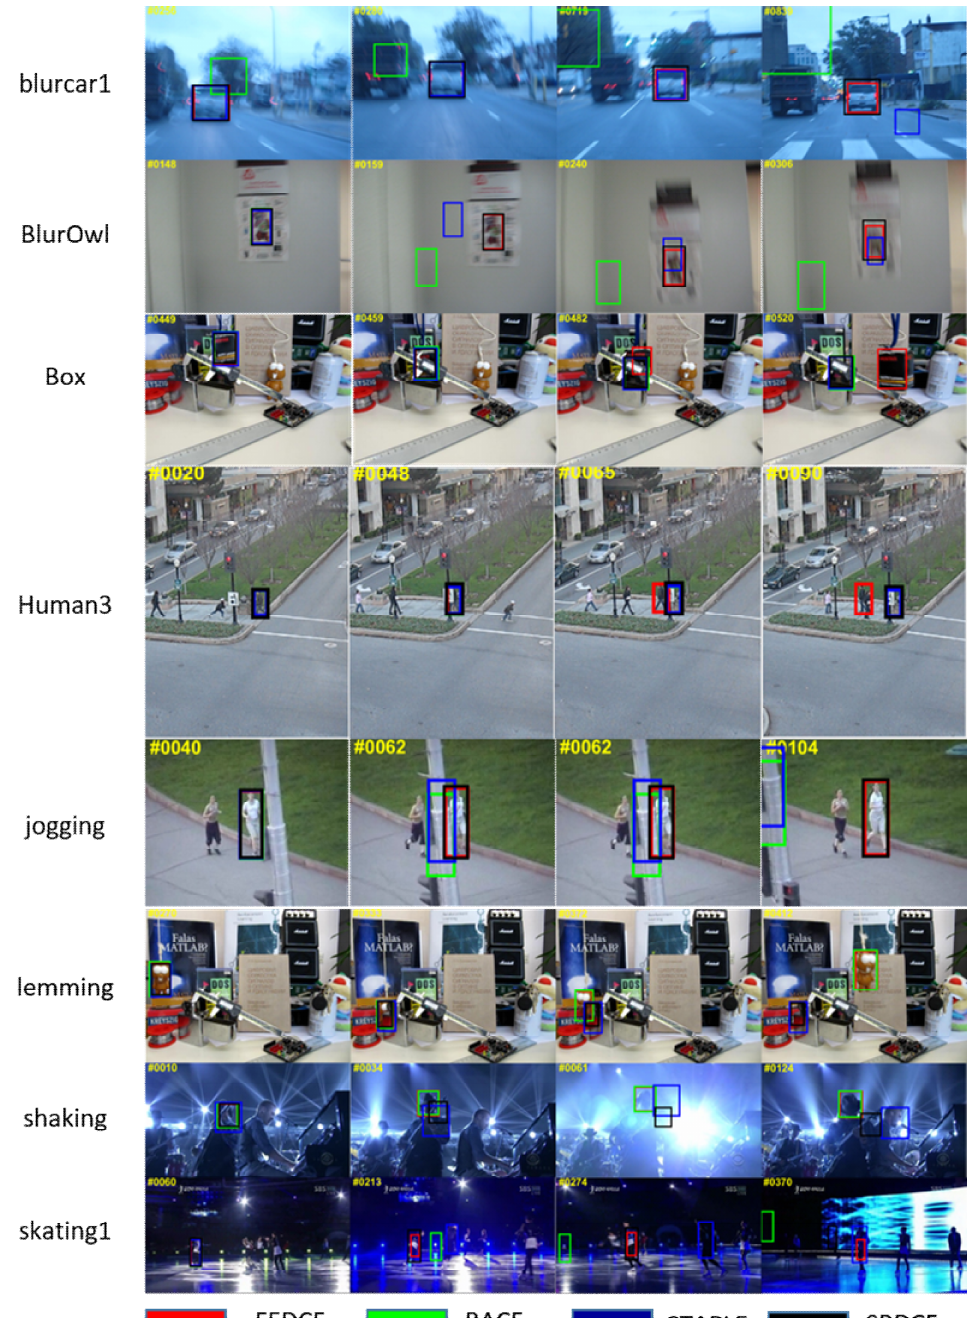
Figure 10. The screenshots of the tracking process on eight challenging sequences. The results of trackers (FEDCF, BACF, STAPLE and SRDCF) are respectively marked with red, green, blue and black rectangles.